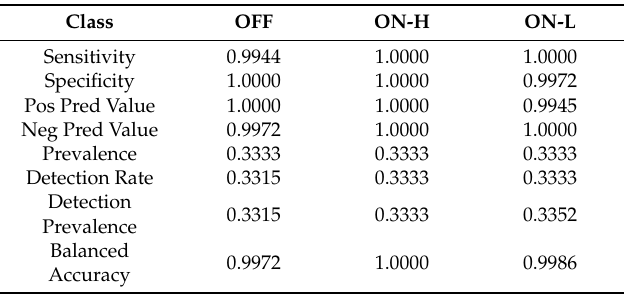
Table 7. Associated statistics of the confusion